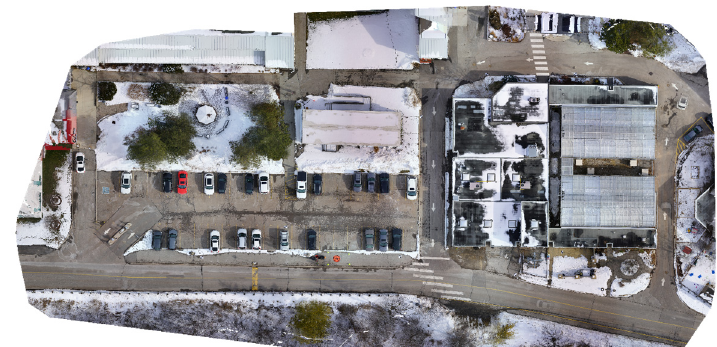
Figure 6. RGB orthomosaic image for the first test site.